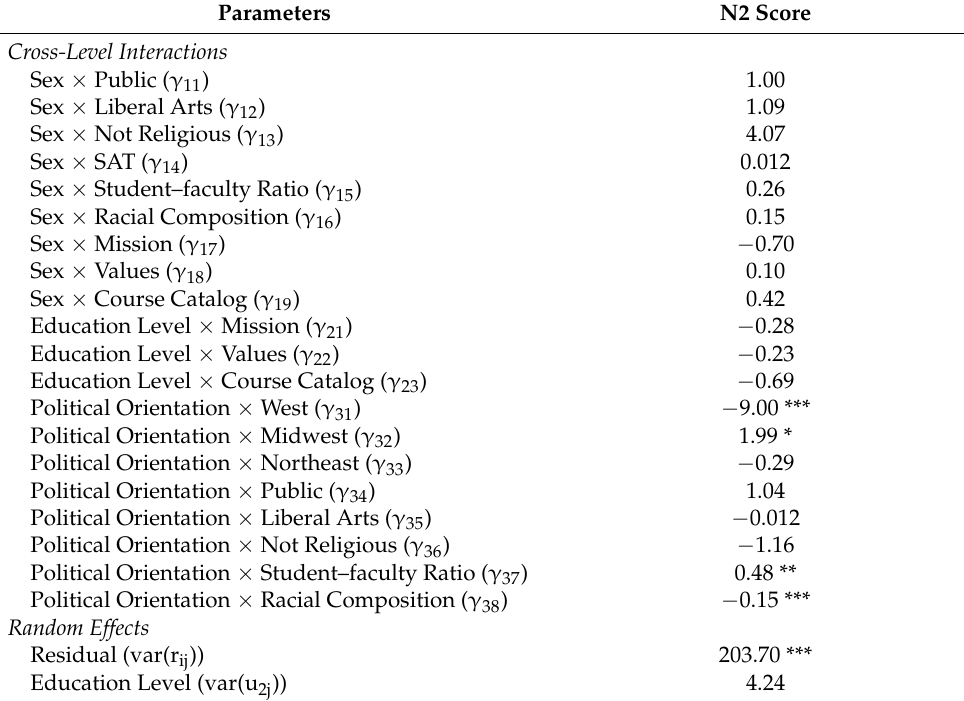
Table 3. Parameter Estimates for Cross-Level Interactions and Random